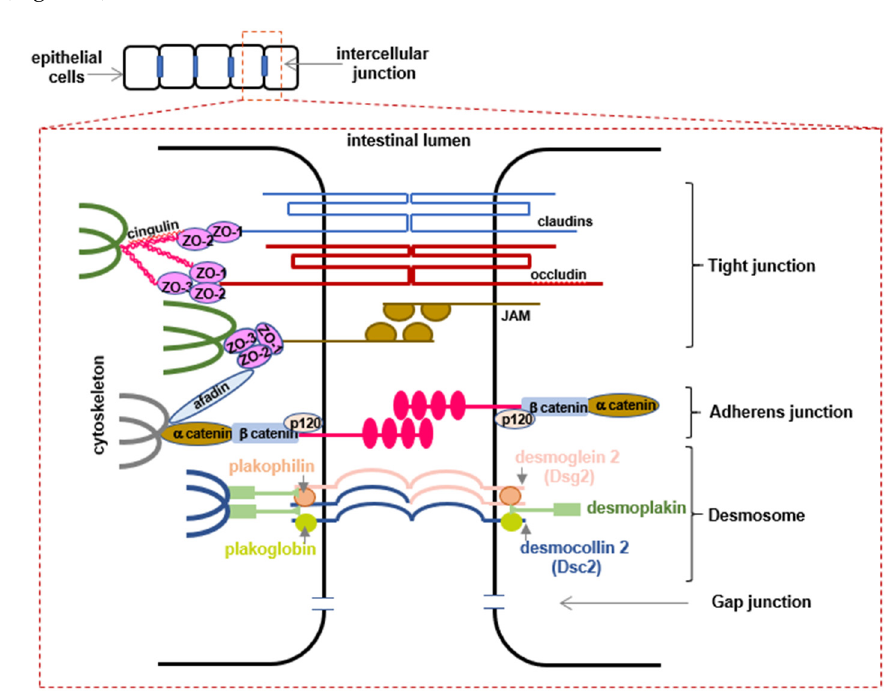
Figure 3. A representative schematic of the intercellular junctions in the intestinal epithelium (according to [5,54,55]). The intestinal epithelium forms a barrier maintained by a structure composed of three junctions: tight junctions (TJs), adherens junctions (AJs), and desmosomes. TJs are generated by membrane proteins, claudins, occludin, and junctional adhesion molecules (JAM) that interact in the paracellular space with proteins on adjacent cells, completely closing the apical intercellular space, blocking microbial penetration, and regulating the selective passage of macromolecules. TJ complex is connected to the actin cytoskeleton through adaptor proteins zonula occludens-1 (ZO-1), ZO-2, ZO-3, as well as other proteins (cingulin, afadine). The lower junctional complexes, AJs, and desmosomes provide adhesive and mechanical properties that contribute to the barrier functions. AJs are created mainly by membrane E-cadherins that form homophilic cell- cell interactions and are intracellularly connected with catenins ( α -catenin, β -catenin, p120 catenin) through which they link E-cadherins with a cytoskeleton. Desmosomes are composed of desmoglein 2 and desmocollin 2, forming homo- and heterophilic interactions. They are linked to plakophilins and plakoglobin via the cytoplasmatic domain. These in turn are connected to the intermediate filaments by desmoplakin.